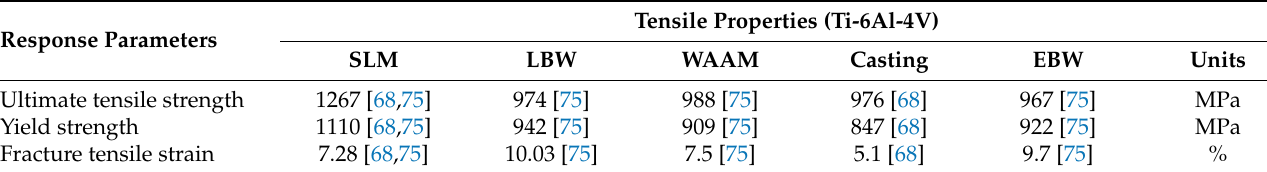
Table 1. Tensile properties of Ti-6Al-4V fabricated by different